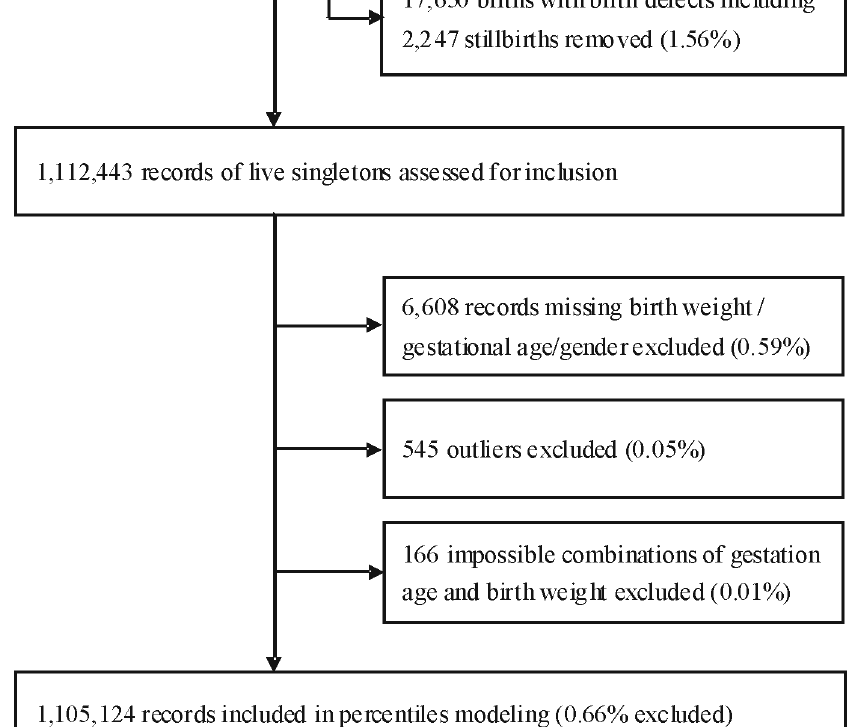
PLOS ONE | www.plosone.org